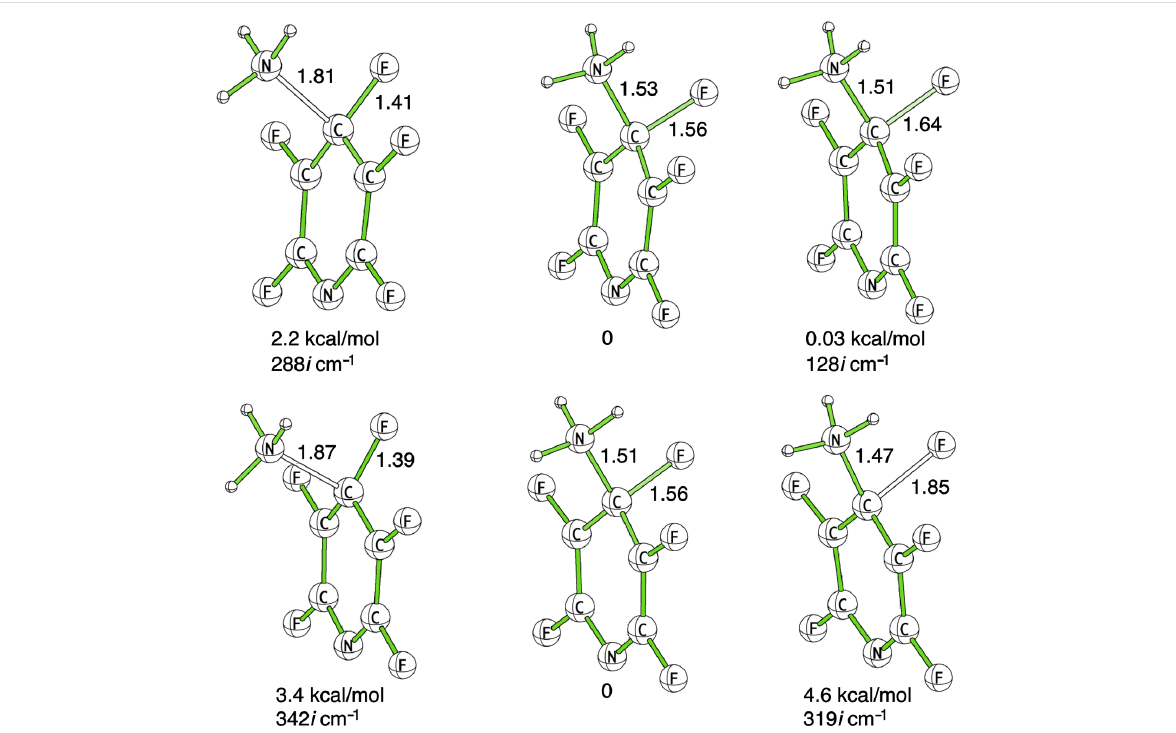
Figure 5: Optimized geometries, relative energies, and imaginary frequencies for the transition states and the σ -complex (middle structure) formed in the reaction between ammonia and 4 . The top and bottom rows show the results from optimizations at the B3LYP/6-31+G(d,p) and M06-2X/6- 31+G(d,p) levels of theory,